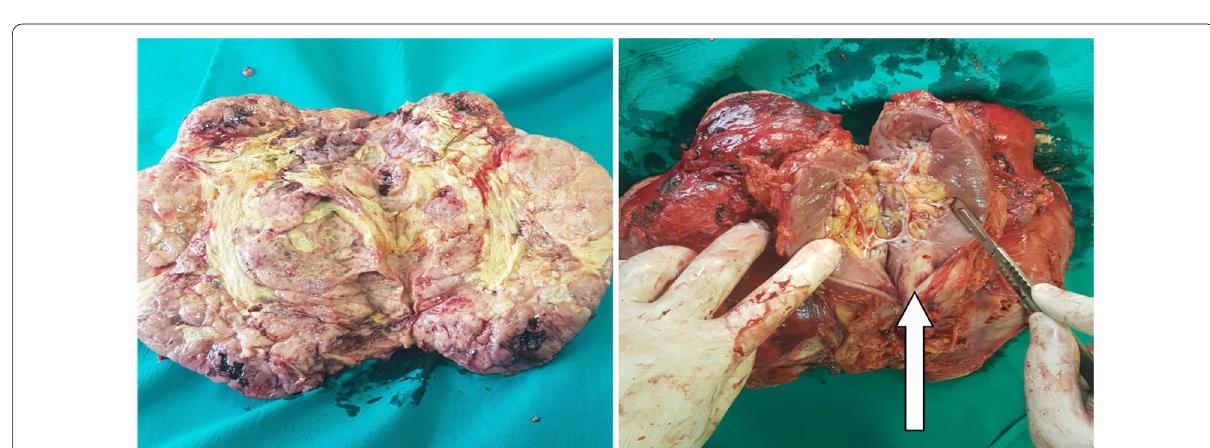
Fig. 2 Left: medial side of the tumor. Right: lateral side with kidney and tumor in lover pole